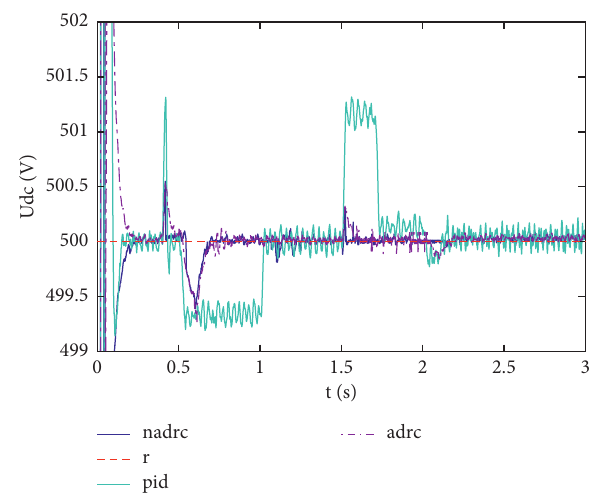
Figure 5: Response curves of the DC bus